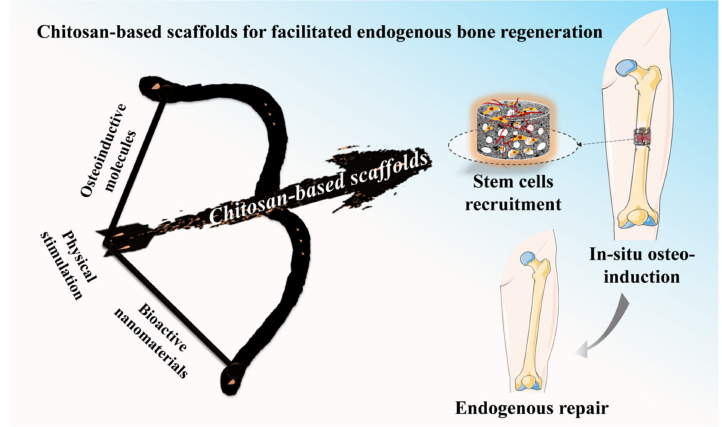
Figure 1. Multifunctional design of chitosan-based scaffolds and the application in facilitating endogenous bone regeneration.